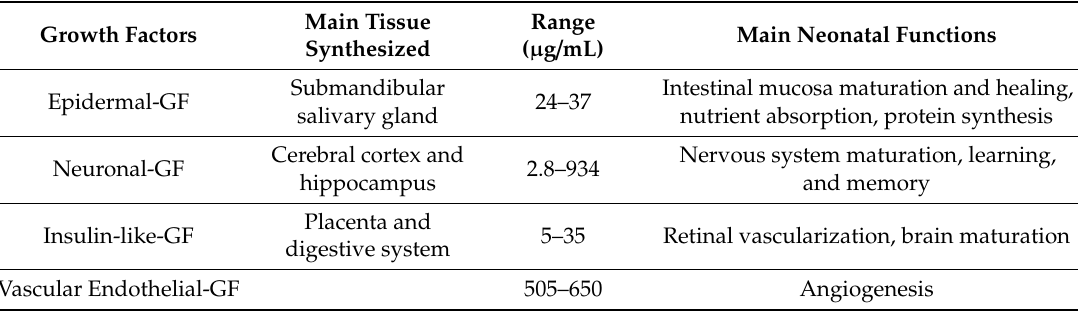
Table 3. Growth factors in